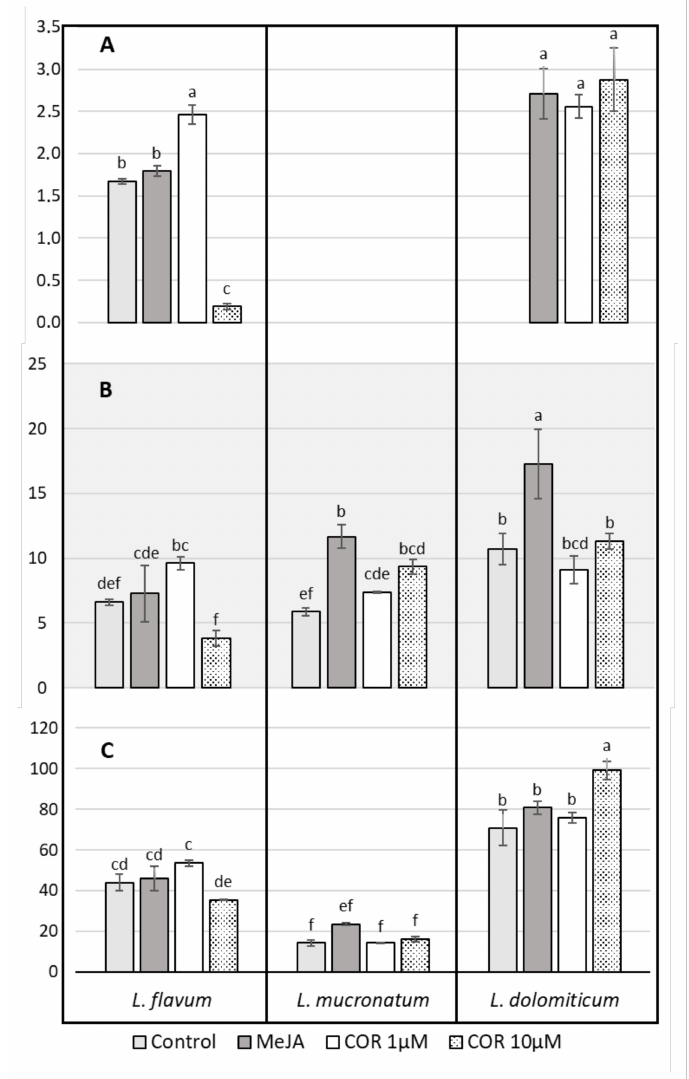
Figure 5. ATL content (mg/g DW): ( A ): PTOX; ( B ): MPTOX; ( C ): MPTOX–Glc. Control (light gray), MeJA (100 µ M, dark gray), COR 1 µ M (white), COR 10 µ M (dotted). Each value is the mean of three biological replicates ± SD. The samples with different letters are significantly different at p ≤ 0.05 according to Duncan